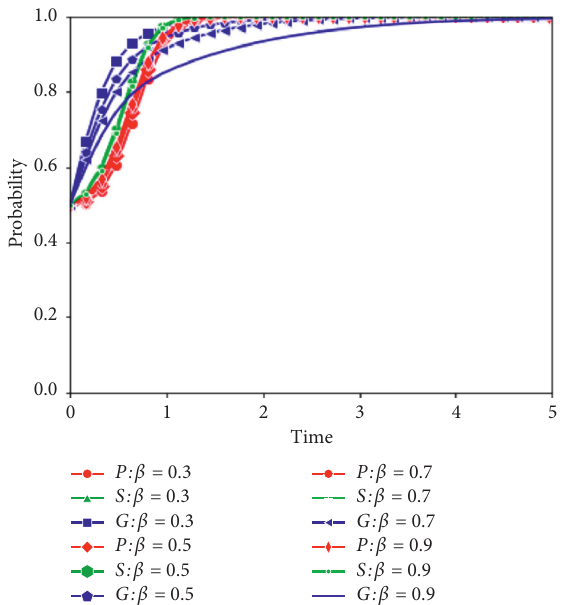
Figure 9: Dynamic evolution process of the tripartite game sub- jects when β changes.